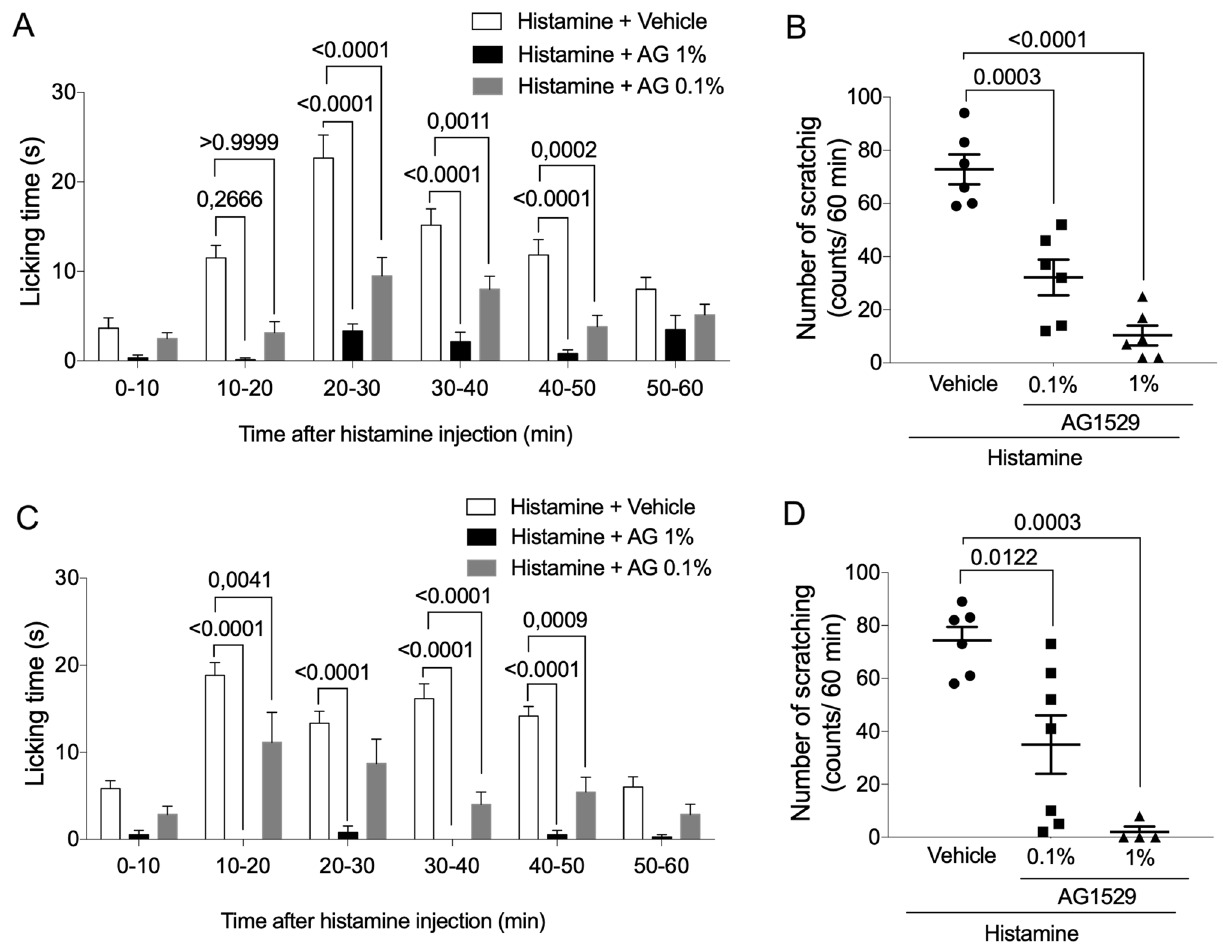
Figure 9. Topical application of AG1529 inhibits histamine-evoked pruritus. Effect of AG1529 (0.1 and 1%) dissolved in acetone ( A , B ) or formulated in a dermal ointment ( C , D ) on the scratching behavior of rats locally injected with histamine in the back of the neck. Animals were injected with 100 µl of a solution at 1 mg/ml of histamine. AG1529 in acetone was wiped in 1 cm 2 area, 30 min before the histamine instillation. Ointment containing AG1529 was applied topically twice/day for 3 days with a spatula in a 1 cm 2 shaved area in the back of the neck. Data are expressed as mean ± SEM, n = 6 animals per group. Data were analysed using the One-way Anova followed by the Bonferroni´s post-hoc test, p-values for statistical difference are indicated. Detail data of the statistical analysis is described in the main